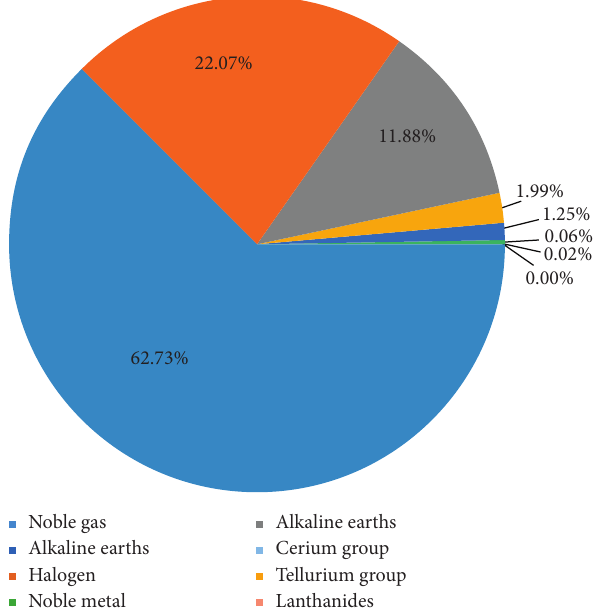
Figure 6: Source term release activity contribution of each of the eight groups.